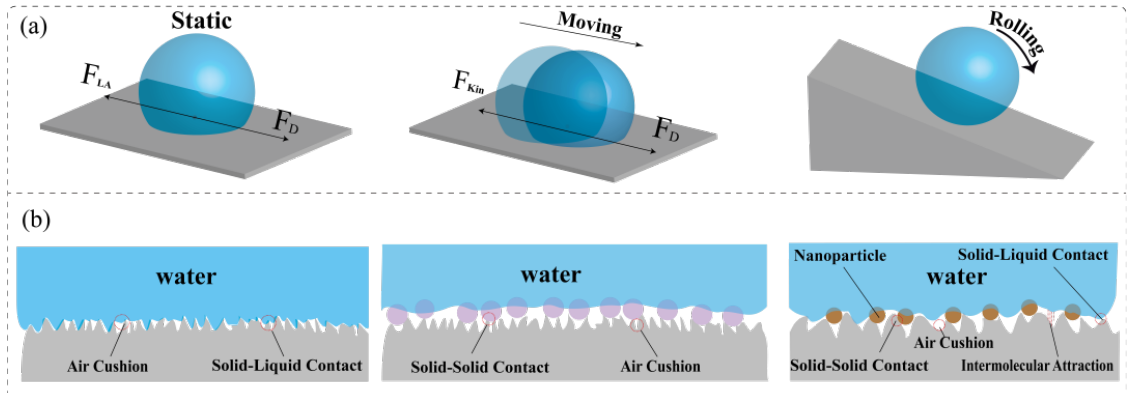
Figure 5. ( a ) Schematic of three different kinematic states of droplets on a solid surface. ( b ) Snapshots of contacting areas for a droplet, a conventional LM, and a monolayer nanoparticle-covered LM on solid substrates, respectively.